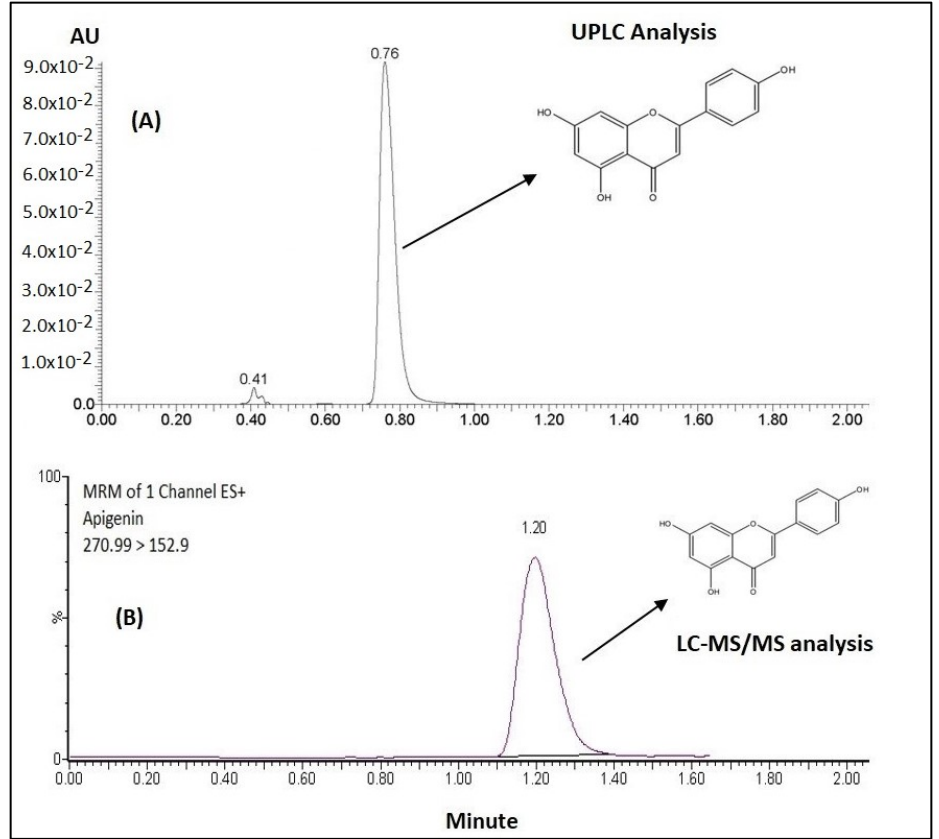
Figure 1. The chemical structure and chromatograms of the apigenin–stable bioactive self-nanoemulsifying drug delivery system (APG-Bio-SNEDDS) by ultra-high-performance liquid chromatography (UPLC) analysis ( A ) and UPLC-MS/MS plasma sample analysis ( B ). (MW: 270.24 g/mol, MP: 345–350 °C).